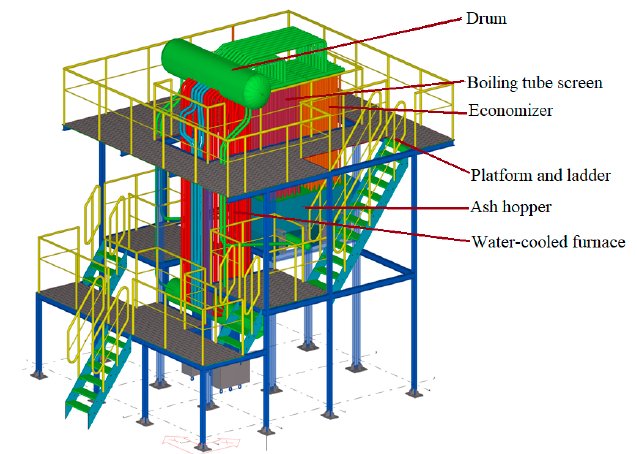
Figure 5. Water-cooled incinerator.